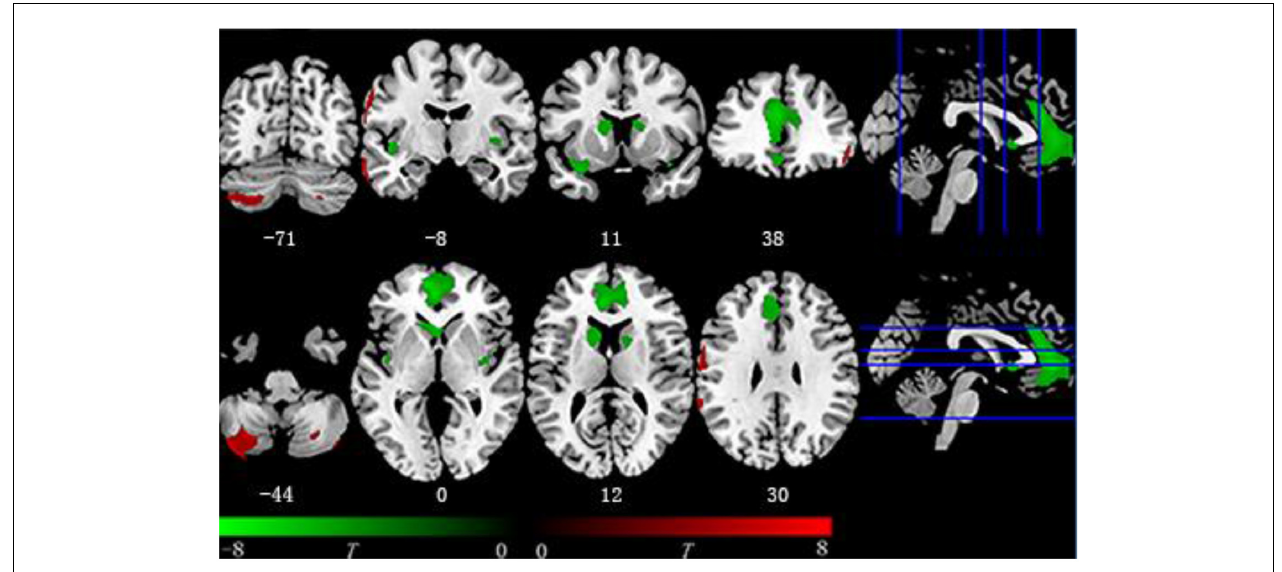
FIGURE 1 | Voxel-based morphometry (VBM) result. Regions covered by green color are negatively associated with body mass index (BMI) while red color represents the opposite. Negative region including bilateral insula, bilateral caudate, and medial frontal region from orbitofrontal cortex (OFC) to midcingulate cortex (MCC). Positive region including bilateral cerebellum and postcentral